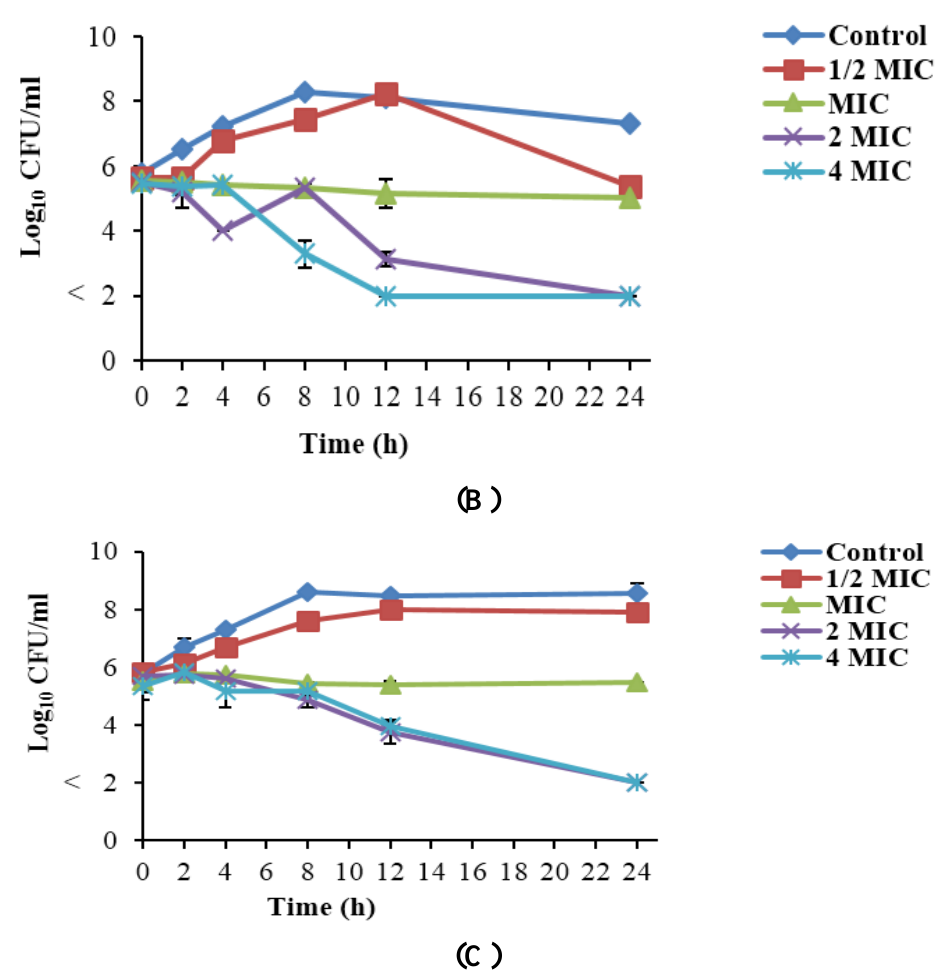
Figure 1. Time-kill curve of Listeria monocytogenes , Scott A ( A ); FSL R2-574 ( B ); and PSU-KV-133 ( C ), after treatment with Rhodomyrtus tomentosa ethanolic leaf extract at various concentrations, as well as the control with 0.1% dimethyl sulfoxide. The detection limit was 10 2